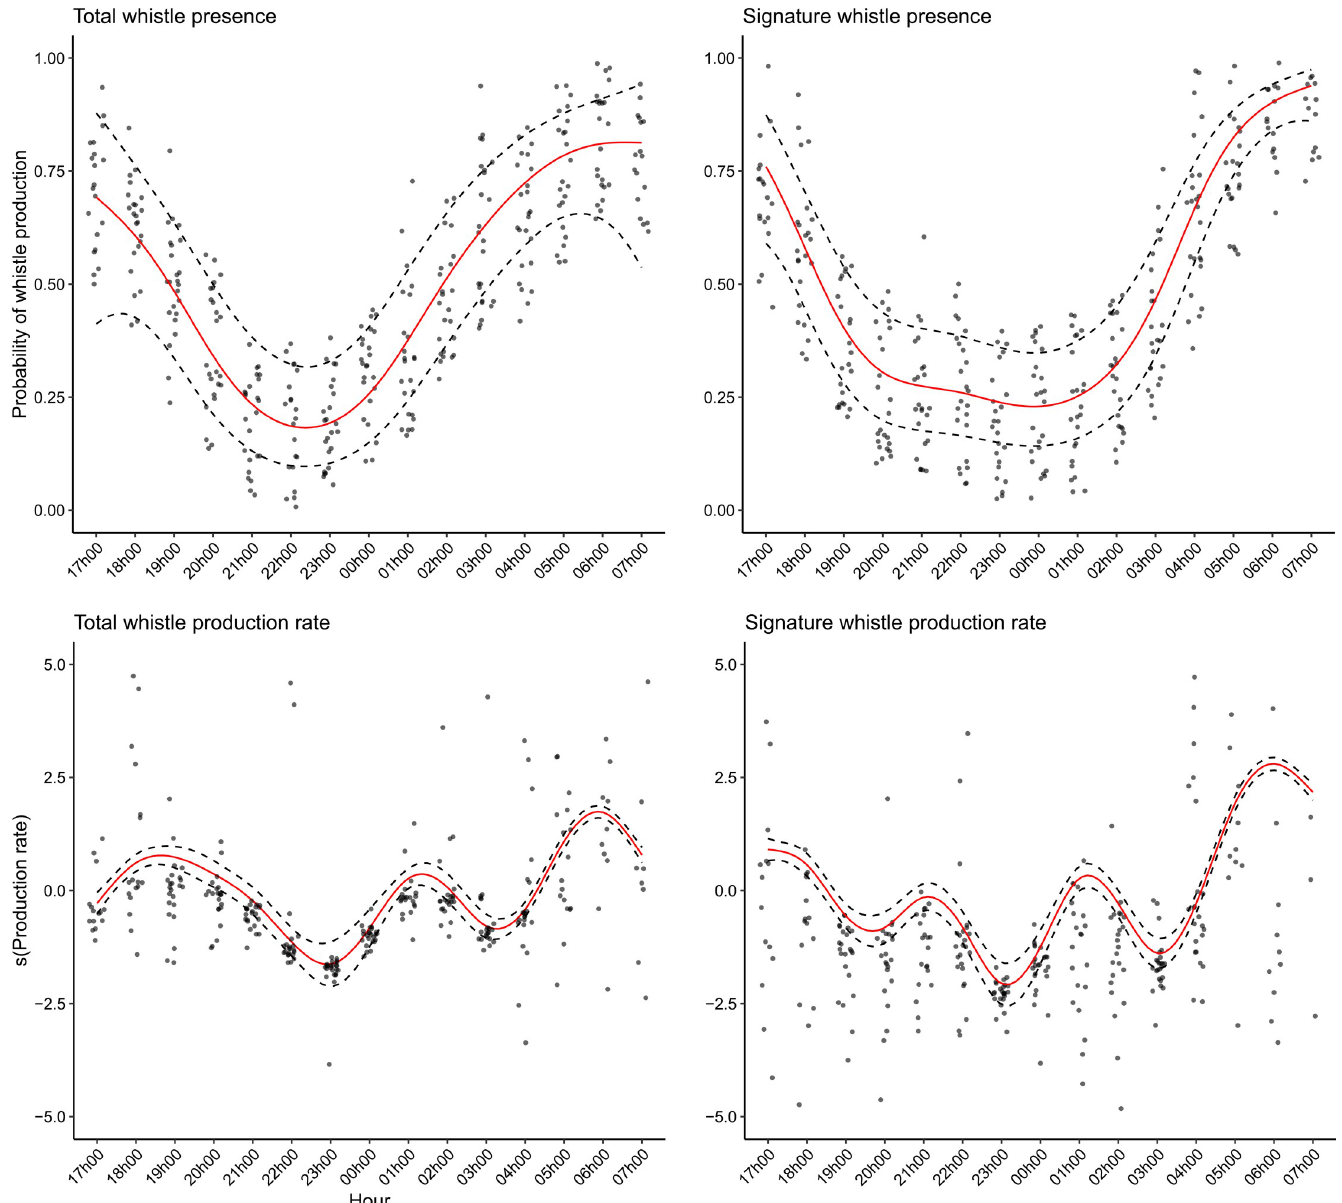
Fig 3. Presence and production rate of whistles and signature whistles over time. This graph shows the GAMM summary of smoothing term ‘hour’ for all four models used in this study. The y-axis represents the log scale of whistle production rate occurring at each time